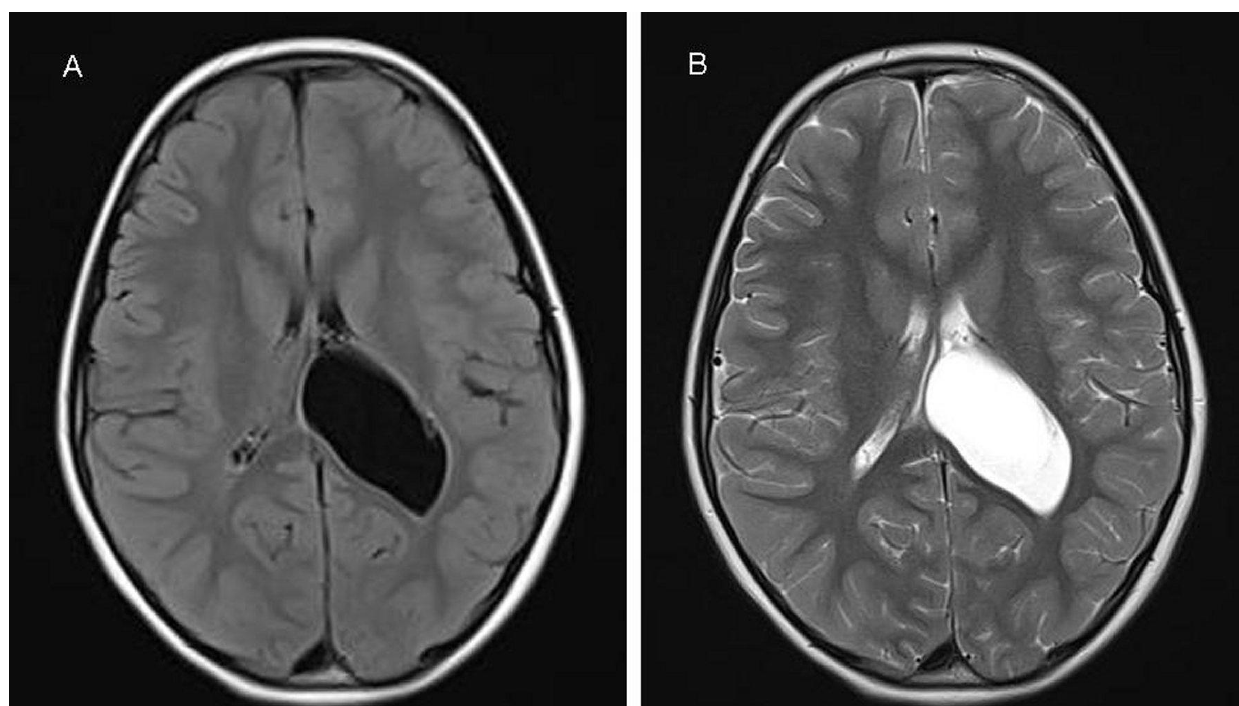
Figure 3 : Brain magnetic resonance imaging. A) Axial FLAIR image: the intraventricular cyst shows the typical water-like loss of signal, confirming its cerebrospinal fluid content. B) Axial T2-weighted image: a thin-walled hyperintense cerebrospinal fluid-like cyst inside the left ventricle is menses appears around 12 months after GnRHa